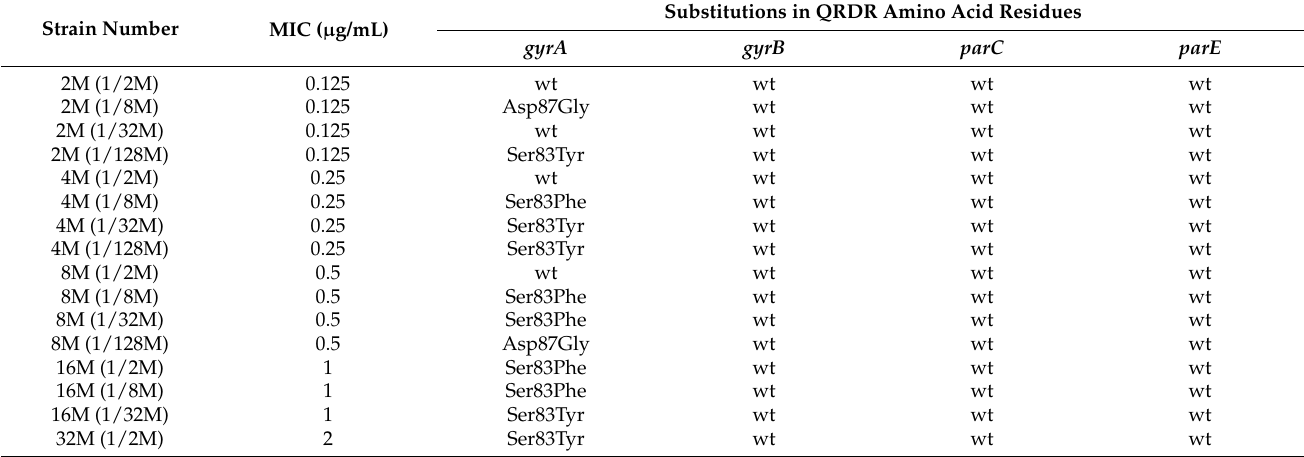
Note: “wt” represented no mutation was